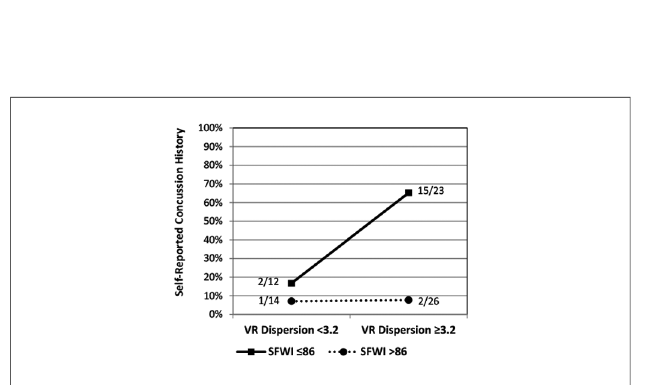
FIGURE 6 Inverse correlation between 12-metric VR dispersion and rate correct per